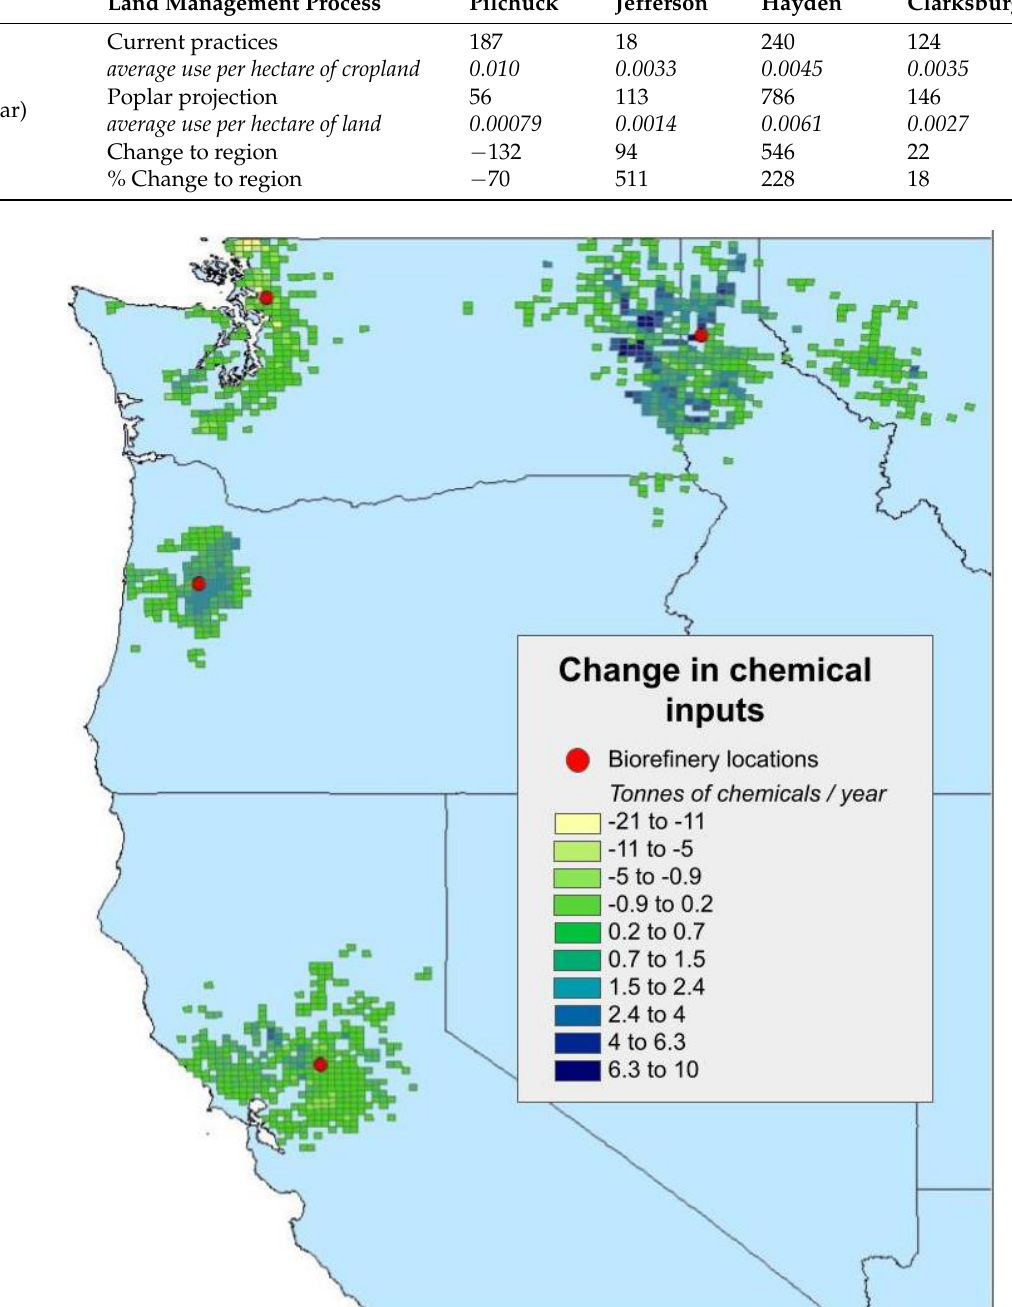
Figure 5. Change in chemical inputs for each pixel as a result of switching from current practices to growing poplar trees for bio-jet fuel production. Chemical inputs include all pesticides, insecticides, and herbicides. Green to yellow indicates a decrease in chemical inputs when switching to poplar. Light blue to dark blue indicates an increase in chemical inputs.